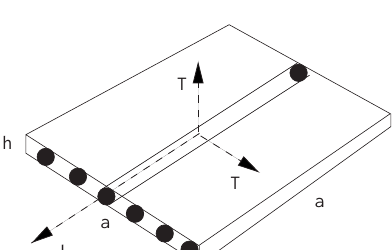
Fig. 2. Isotropic plates.